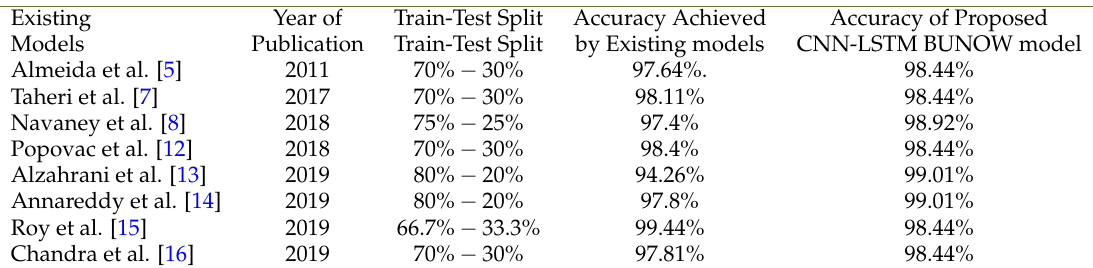
Table 7. Comparison of CNN-LSTM BUNOW model with other existing